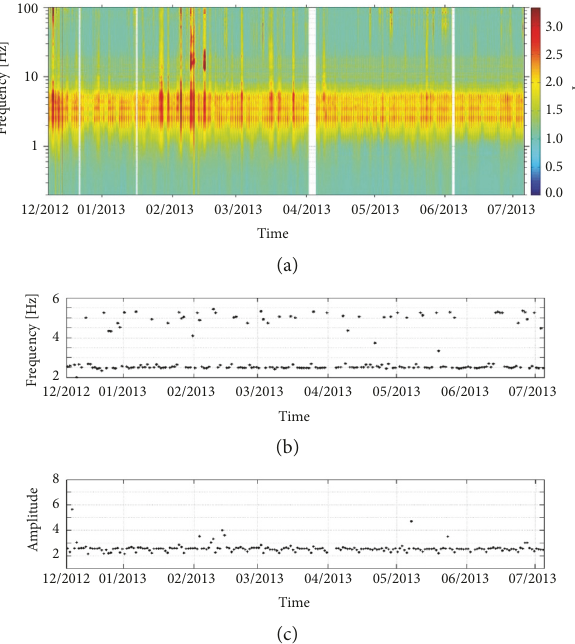
Figure 5: (a) The TOR3 HVSR amplitude, (b) the peak frequency distribution, and (c) the peak amplitude distribution over the whole monitoring